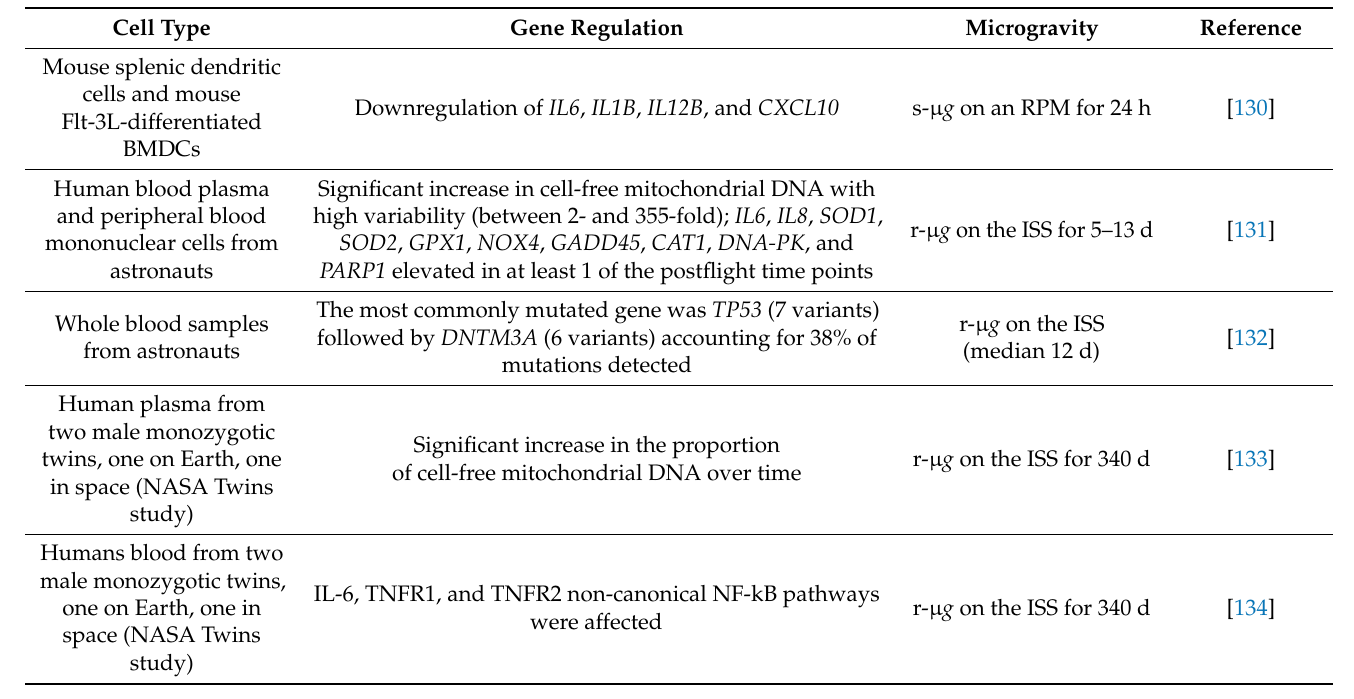
Table 5. Changes in gene regulation of immune system components exposed to microgravity